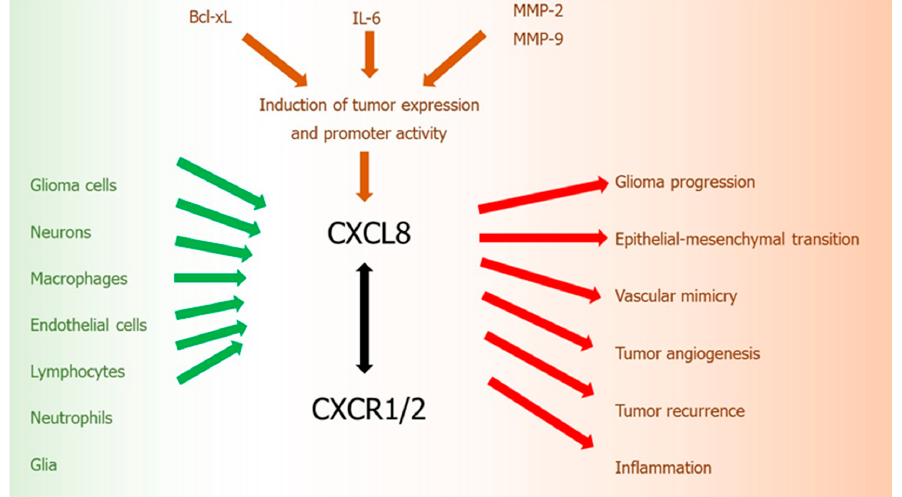
Figure 2. CXCL8-CXCR1 / 2 axis in glioma development. Green arrows: cells secreting chemokine, red arrows: chemokine activity, brown arrows: factors inducing chemokine, black arrow: chemokine-receptor